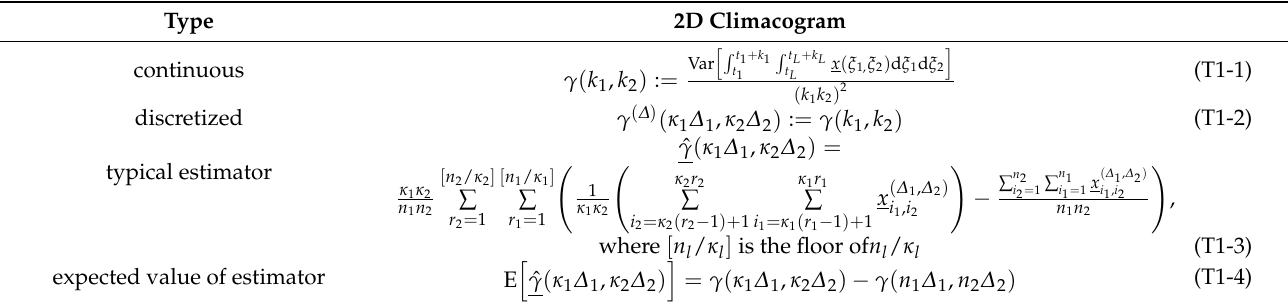
Table 1. Climacogram definition and expressions for a 2D continue process, a discretized one, a common estimator for the climacogram and the estimated value, based on this